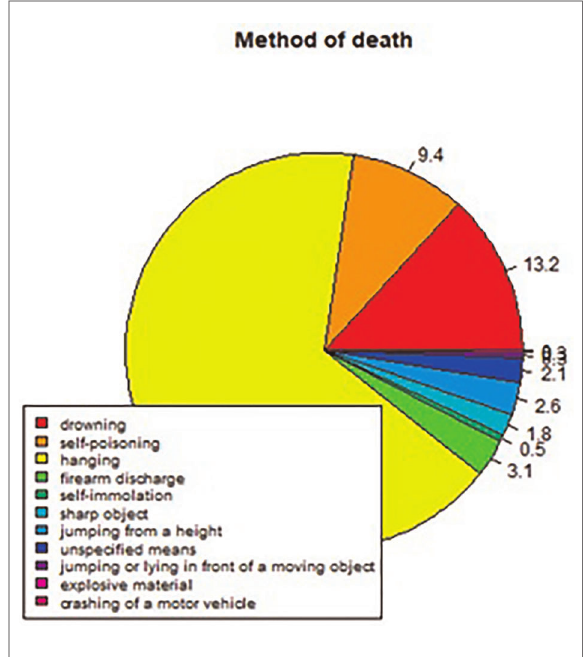
FIGURE 5 Percentage breakdown of the method of deaths by suicide during the period 2008 – 2017 in County